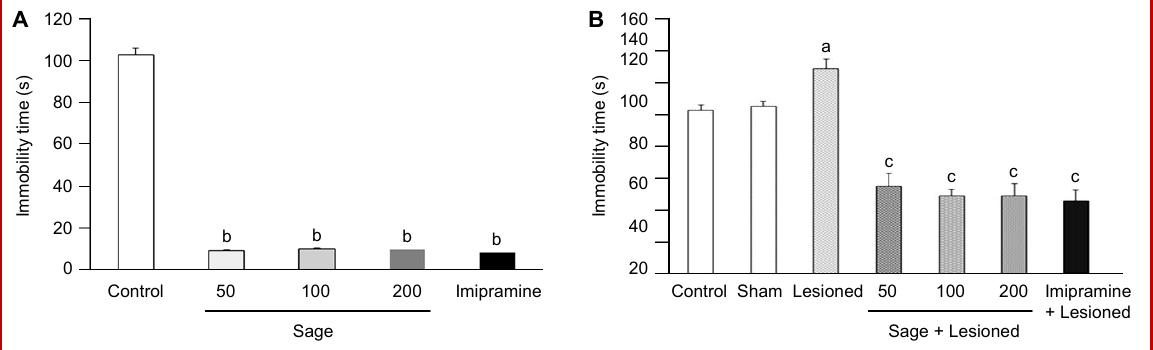
Figure.5. Effect of S. officinalis methanolic extract (50,100 and 200 mg/kg i.p.) or imipramine (30 mg/kg i.p.) on forced swim test immobility time in intact and hippocampal-lesioned rats. Sage methanolic extract or imipramine was injected 30 min before the test. Control group received saline 30 min before the test. Graph A and B shows the duration of immobility in the different tested groups, after treatment with Sage extract or imipramine. Data represent means ± S.E.M, of immobility during the 6-min test session (n= 6 rats per group). Comparisons were made by us- ing a one-way ANOVA followed by post hoc Tukey test: a p< 0.05, b p<0.001compared with control group, c p<0.001 compared with lesioned